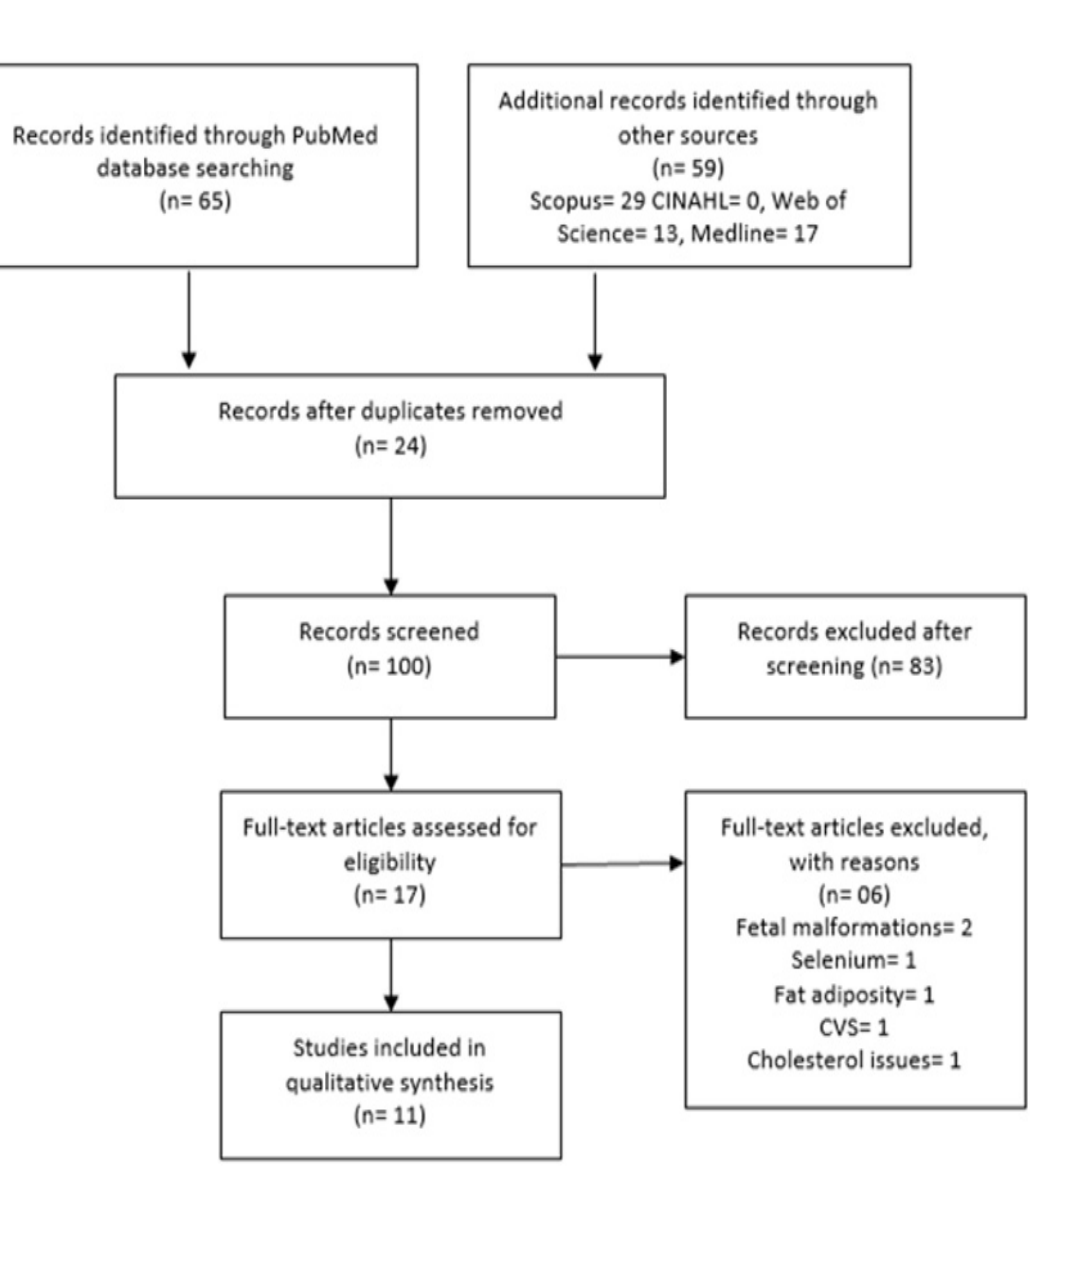
Figure 1. PRISMA Flow Chart for Studies Retrieved Via Searching and Selection Process.